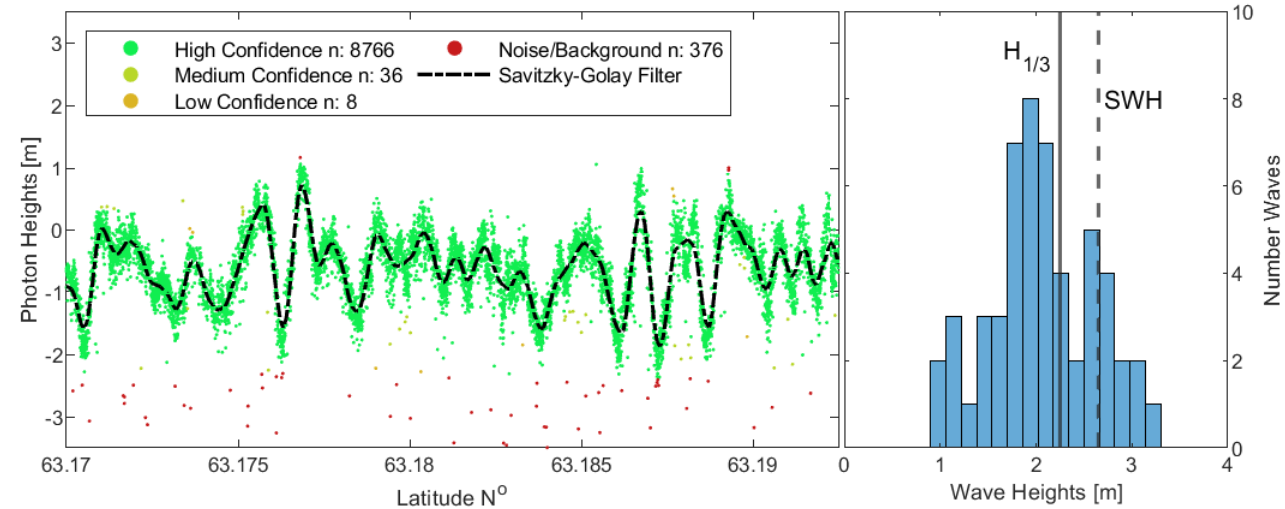
Figure 4. ( Left ) Scatterplot of the geolocated surface photons along a segment of a ground track ( ∼ 2.5 km along the surface) of ICESat-2 granule 10460805 beam GT3L. ( Right ) Histogram of the observed ocean wave heights showing the locations of the highest 1/3 ( H 1/3 ) of wave heights and the corresponding SWH for the 10 km segment starting at the latitude 63.17 ◦